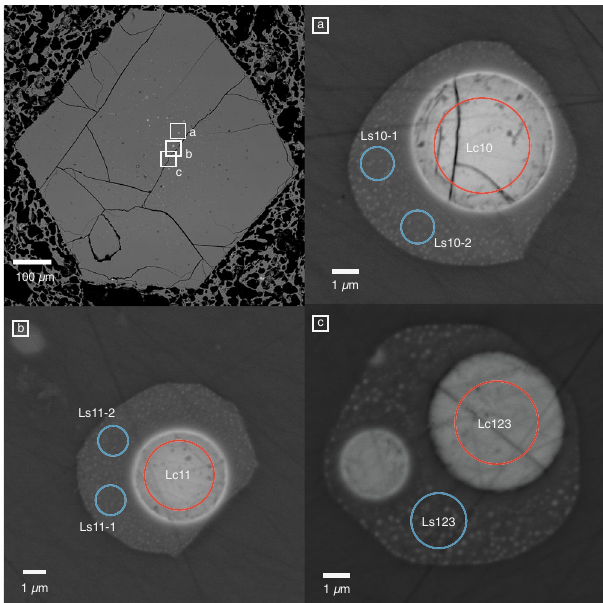
Fig. 2 Liquid immiscibility separation stages. BSE images of melt inclusions showing different separation stages of liquid immiscibility. 1 nuclei formation of immiscible carbonatite liquids (Lc) in silicate (Ls)